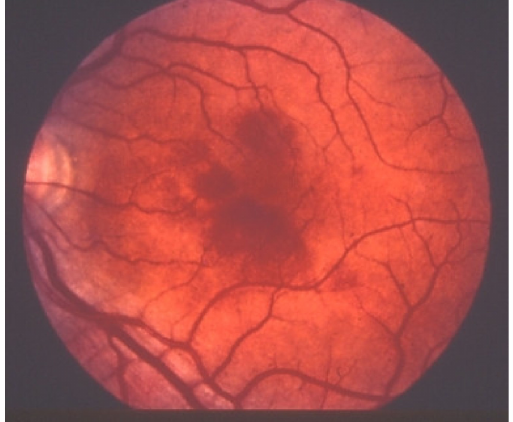
Figure 29. AMN. Fundus appearance. Petaloid